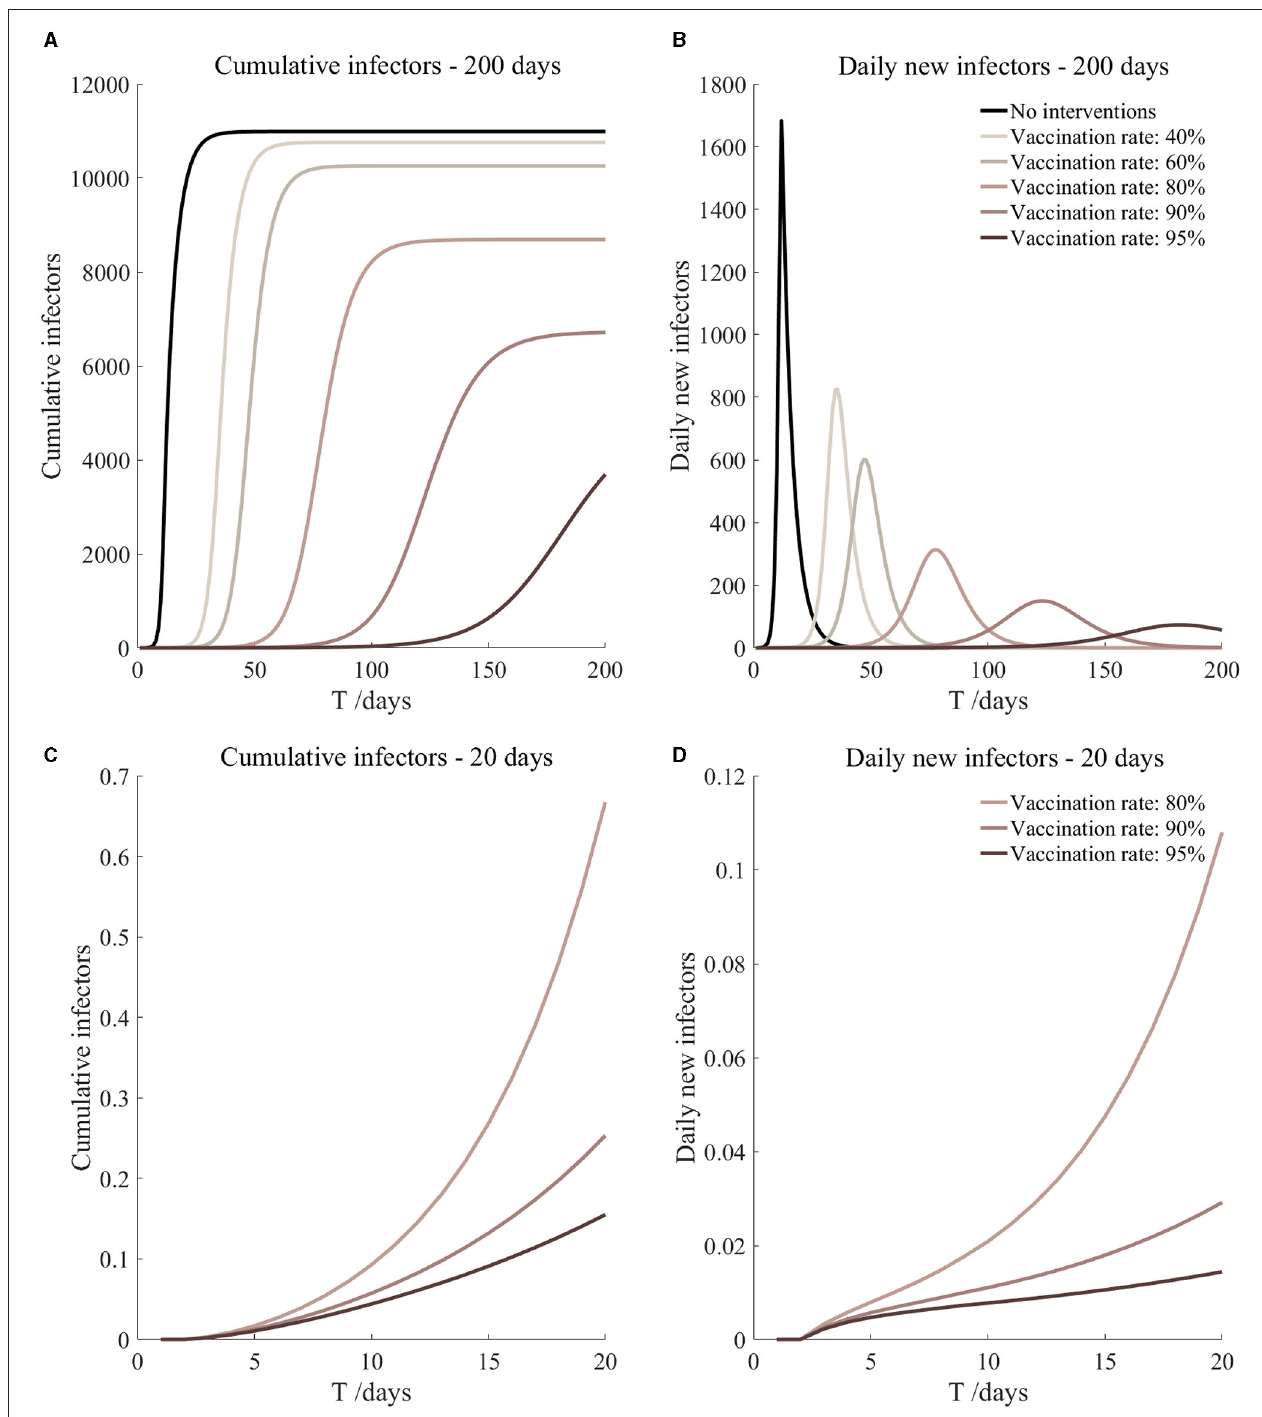
FIGURE 10 | Vaccination and 14-day compulsory quarantine. Assume pre-flight screening can identify 40% of asymptomatic infectors, 14-day compulsory quarantine has about a 4% risk of missed detection.